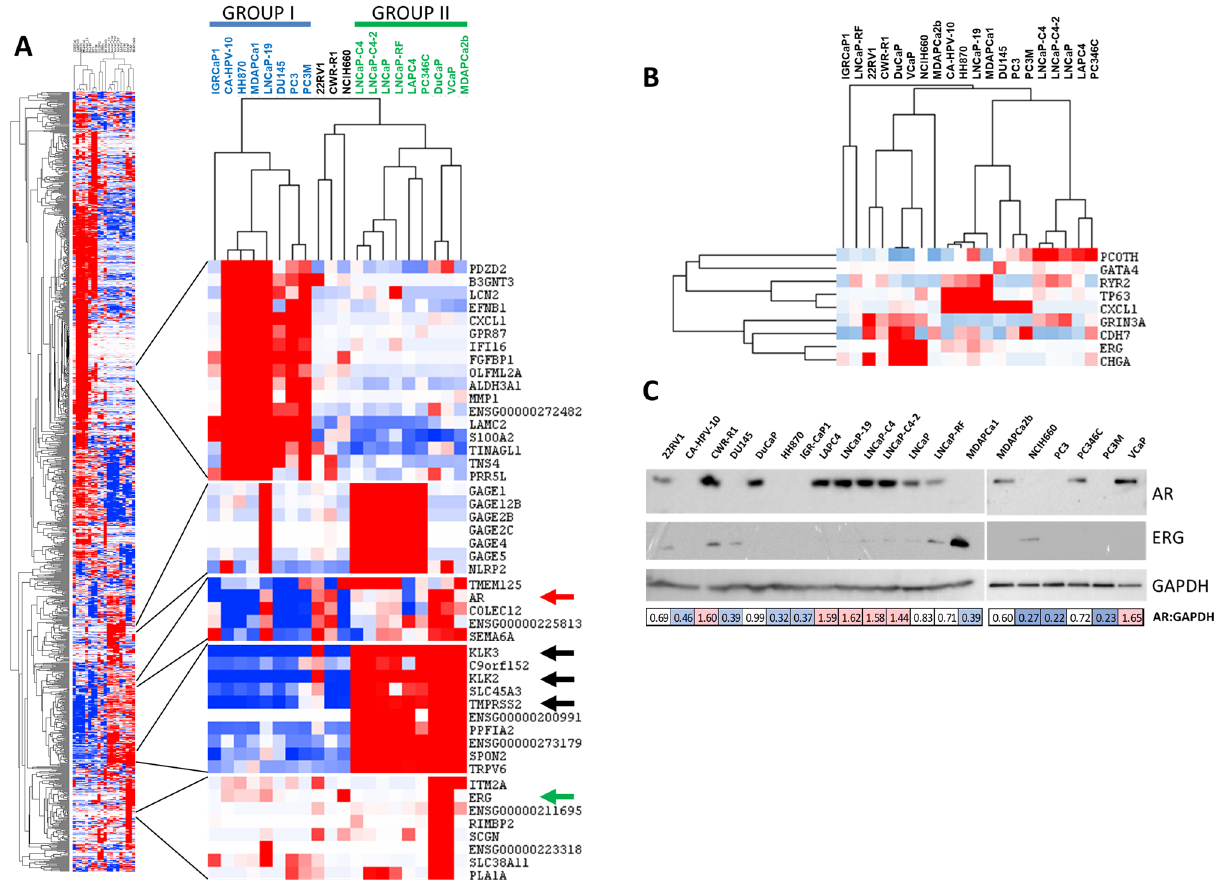
Figure 1. Expression of variable and selected genes and proteins in prostate cancer cell lines. ( A ) Hierarchical clustering of cell lines and the thousand most variable genes reveals distinct clusters. Several of the clusters are directly related to AR function and activity. PSA ( KLK3 ) is the most variably expressed gene in the panel, but only shows weak correlation with AR expression. Similarly, TMPRSS2 and ERG also show weak associations with AR RNA expression. An additional cluster of testes antigen genes is strongly expressed in LNCaP cells and derivatives, as well as several additional cell lines. ( B ) Clustering of cell lines mirrors clustering prostate tumors using genes identified by the TCGA prostate cancer. The clustering of the genes is also highly similar, although CHGA clusters with different genes in our data set. Furthermore, expression of PCOTH and GATA4 are extremely low in the cell lines, suggesting that their expression may be confined to stromal cells in vivo. ( C ) Western blot analysis of AR and ERG expression in the prostate cancer cell line panel. Cropped images highlighting the bands specific to AR and ERG are shown. Relative AR:GAPDH expression levels are shown below, color coded by low (blue), moderate (white), and high (red) AR:GAPDH Full, unaltered blots are available in supplementary Fig.